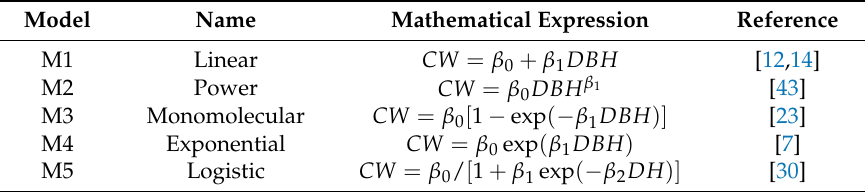
Table 2. Simple linear and nonlinear models for crown width